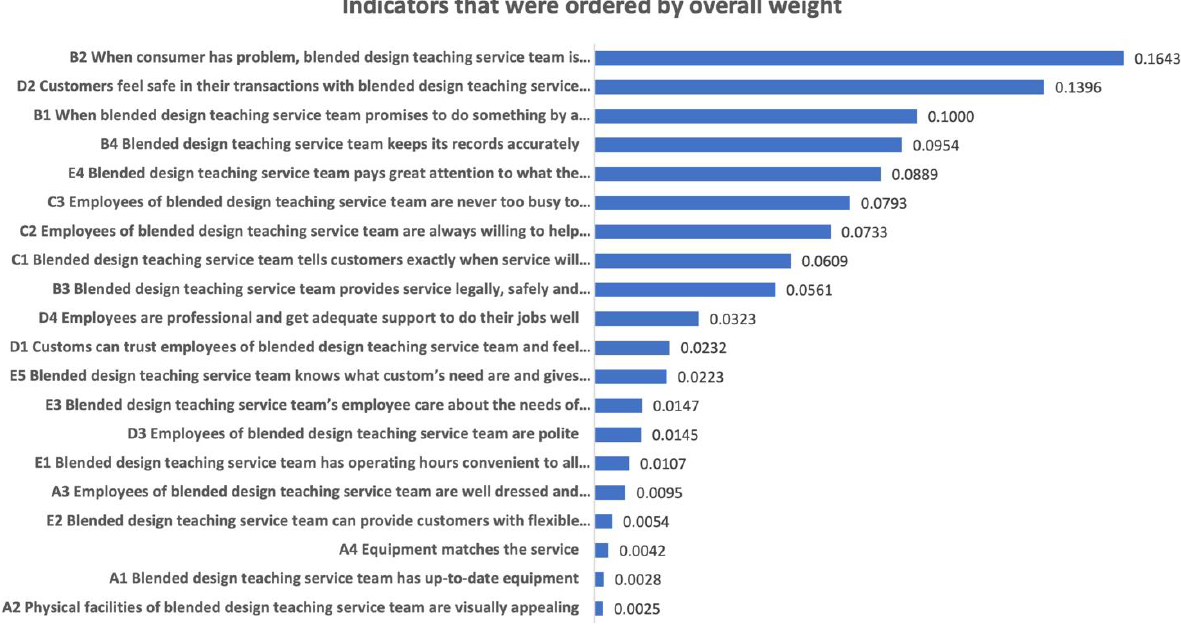
Figure 6. The overall weight and ranking of indicators.